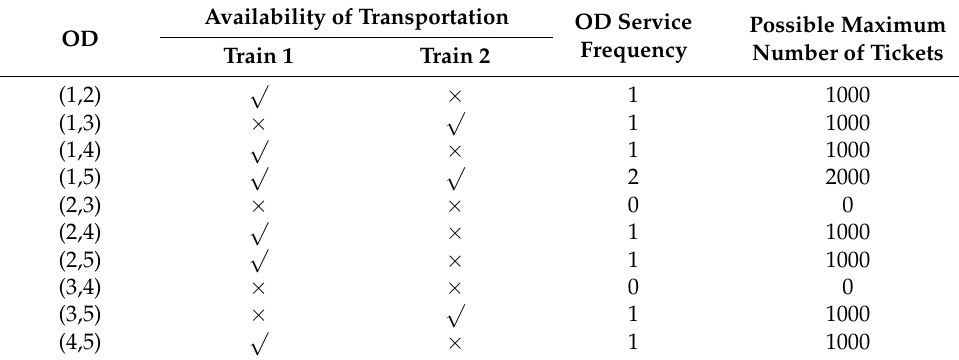
Figure 2. An example of a train stop plan. Table 2. Transportation supply provided by the sample stop plan.